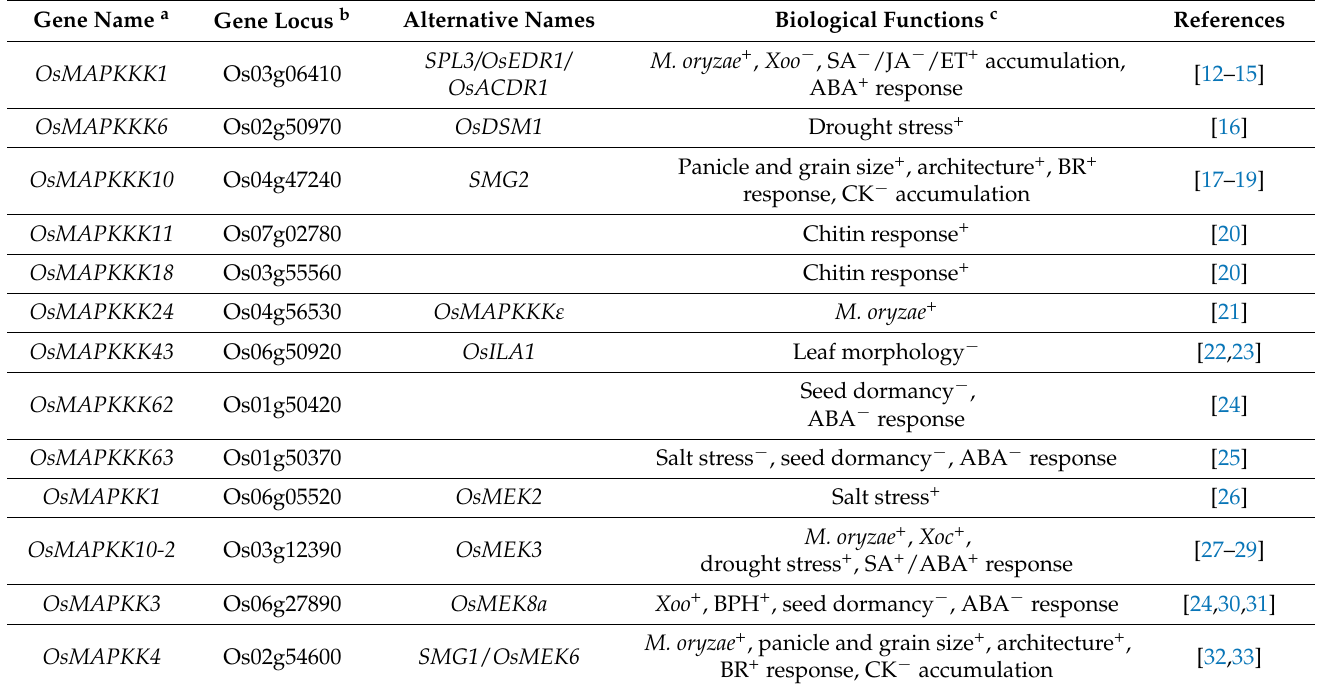
Table 1. Function characterized rice MAPK